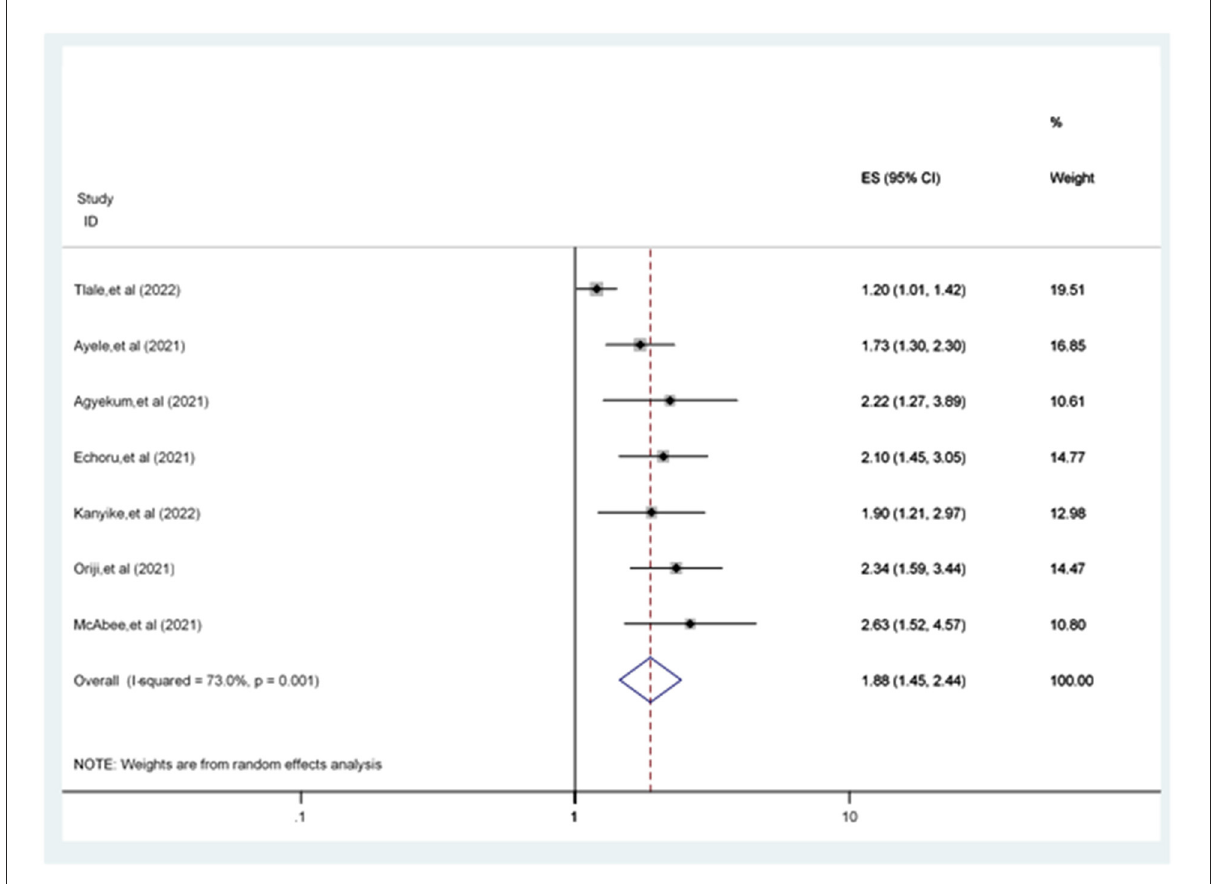
FIGURE6 Forest plot revealing the relationship between sex and COVID-19 vaccine acceptance among the study